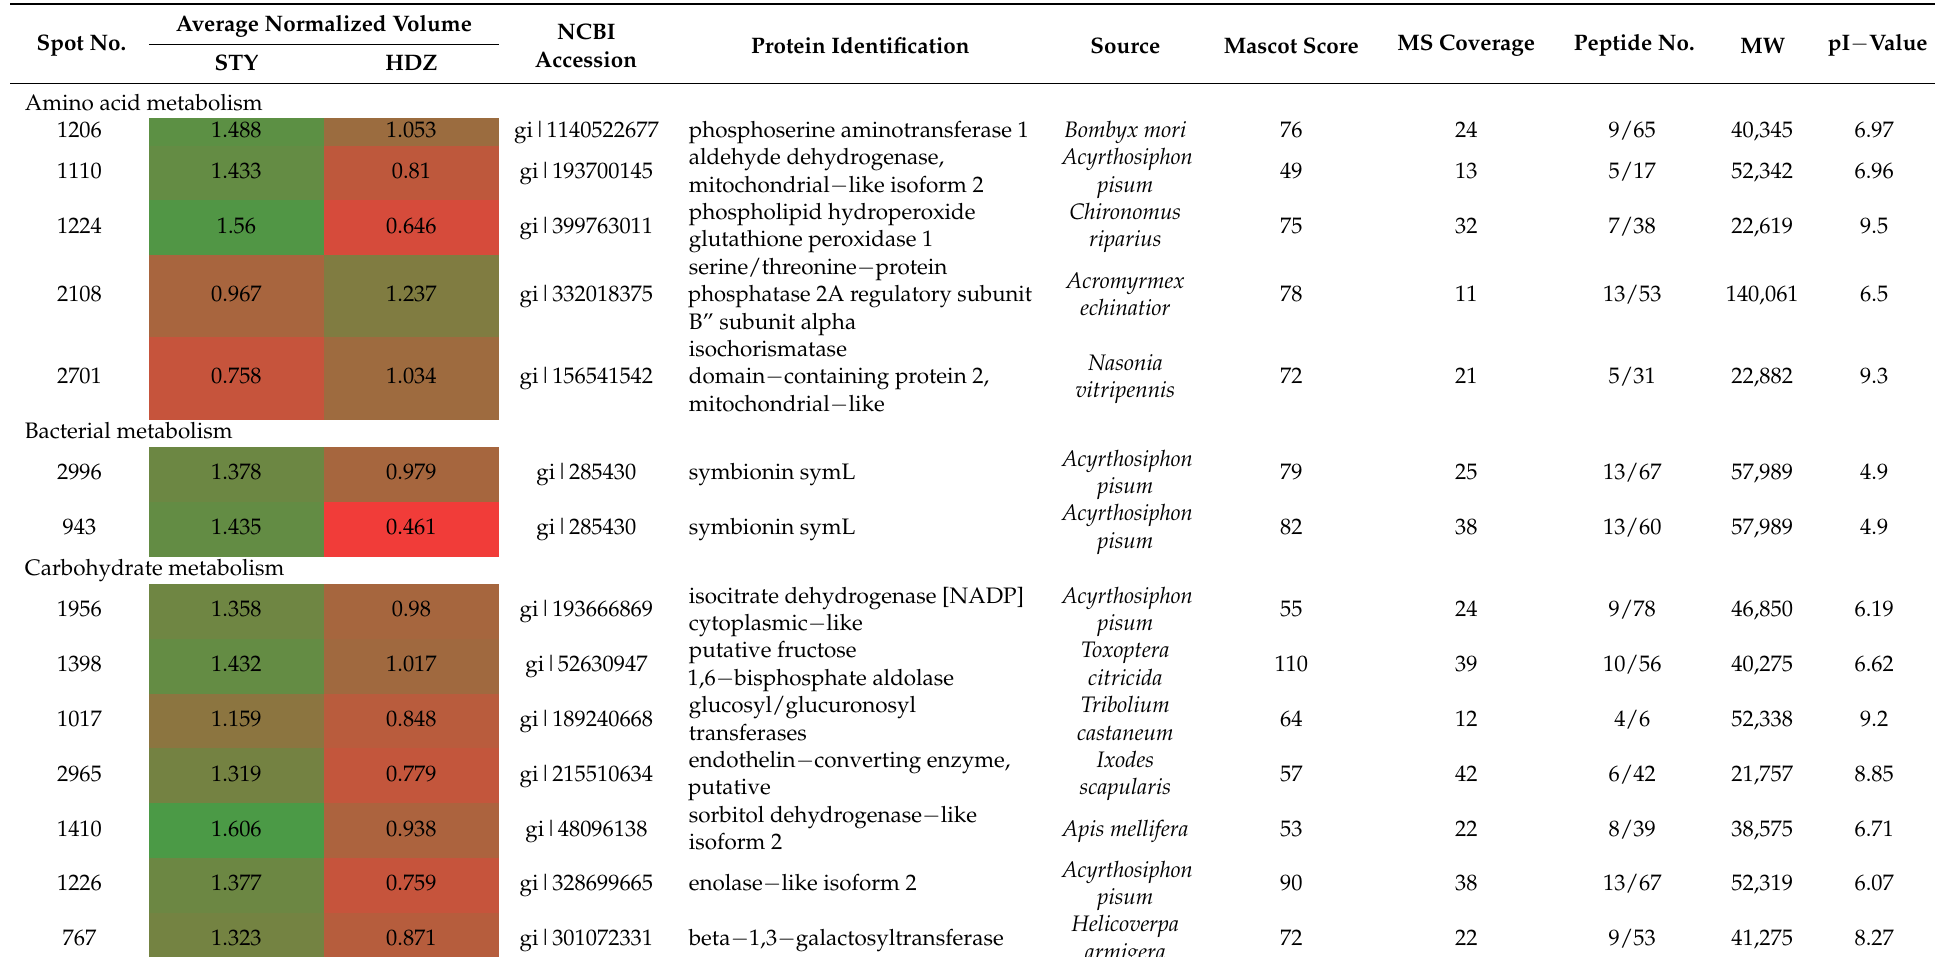
Table 3. List of identified proteins and related metabolic pathways in